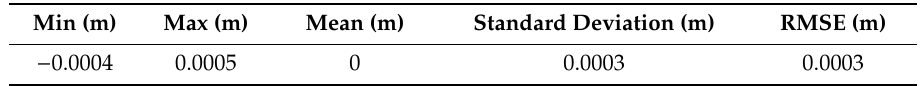
Table 20. Statistical values of the residuals for the North coordinates after reprojection from WGS84 ellipsoidal coordinates to OSPM /